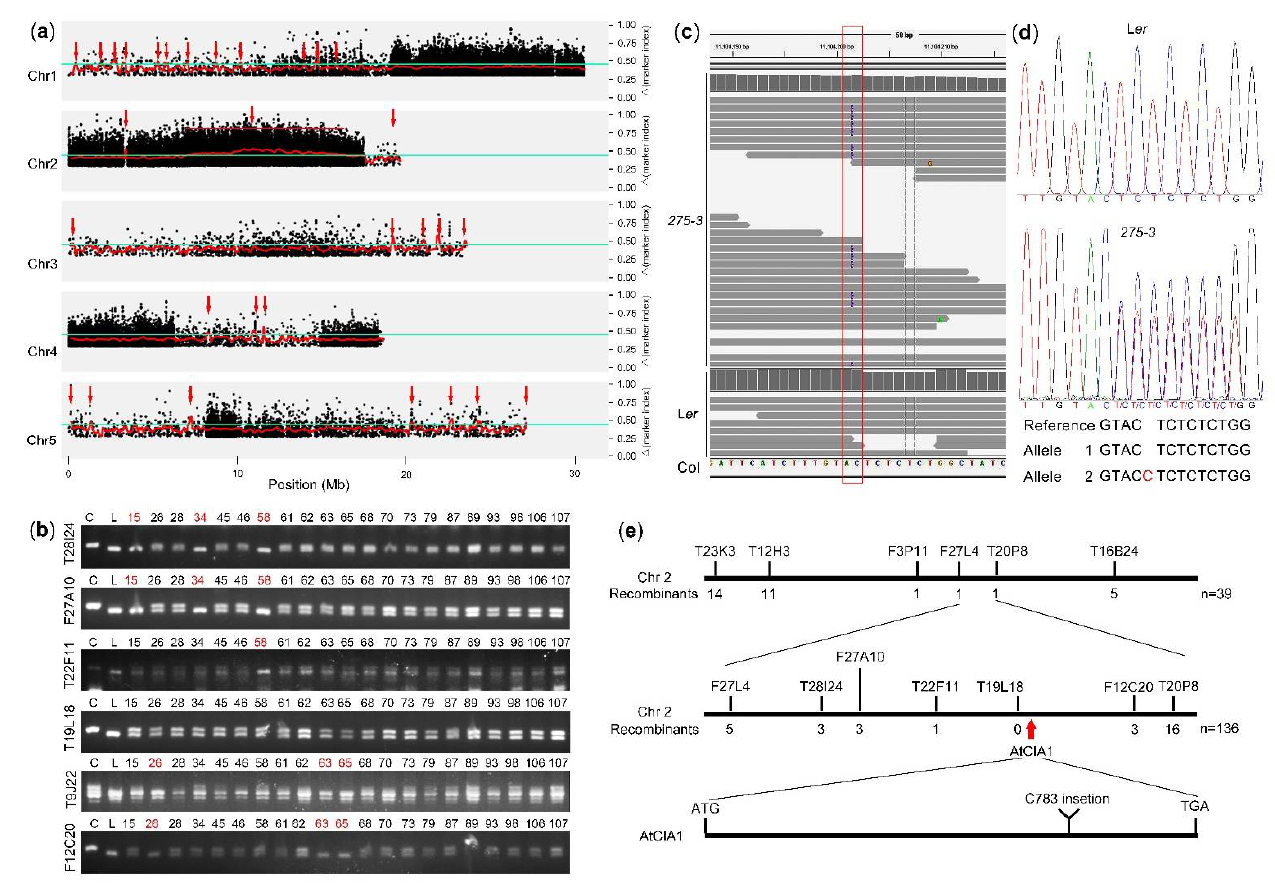
Figure 4. The cloning data of CIA1 in the mutant 275-3 of Arabidopsis . ( a ) The Δmarker-index plots of the mutant 275-3 generated by the analysis of MutMap. The red lines represent the sliding window average Δmarker-index values of the 100Kb interval with 20kb increments. The blue lines indicated the threshold 0.45 to identify the candidate regions. ( b ) The PCR results of some SSLP markers in the fine mapping of 275-3. The plants of recombinants at F27L4 or T20P8 were used to analyze the recombinants at some markers (at the left side) and the red numbers indicate the recombinants. T28I24, F27A10, T22F11, T19L18, T9J22 and F12C20 are located around Chr2: 10,382,120 bp, Chr2: 10,516,283 bp, Chr2: 10,779,026 bp, Chr2: 11,061,880 bp, Chr2: 11,328,569 bp and Chr2: 11,462,271 bp, respectively. C, Col; L, L er . ( c ) The whole-genome sequencing results at the mutated site in 275-3 and WT using the IGV software. ( d ) The sequencing results of DNA fragments containing the mutated site in WT and 275-3 . ( e ) The cloning procedure of CIA1 in Arabidopsis.